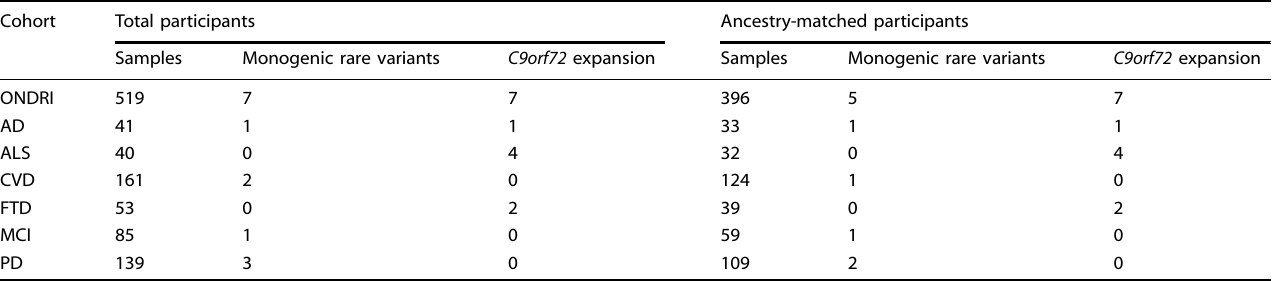
Table 2. ONDRI participants harbouring rare variants likely contributing to Mendelian forms of neurodegenerative disease and cerebrovascular disease.